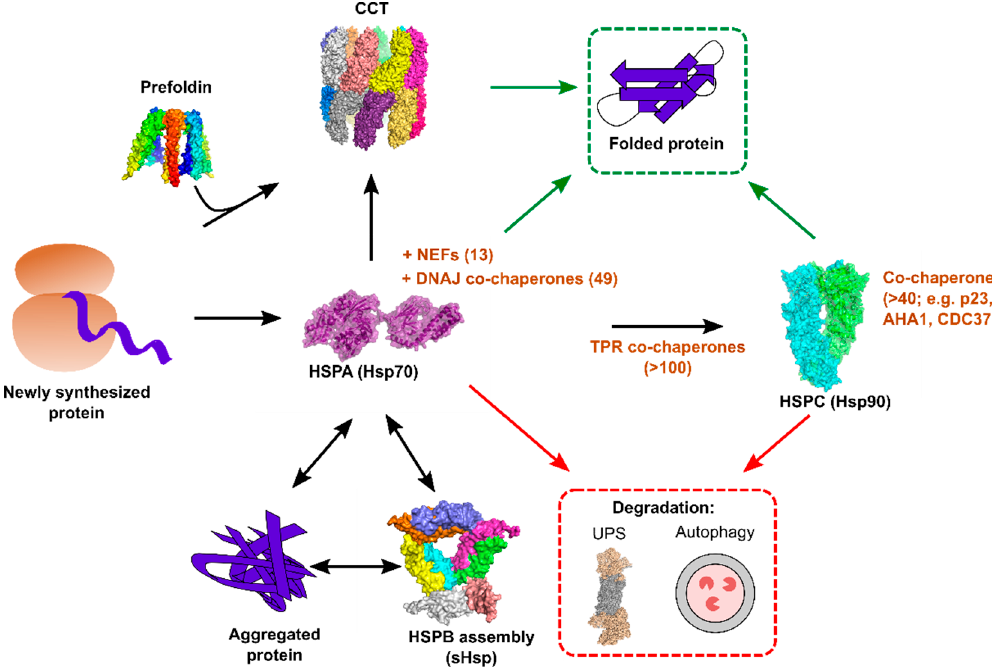
Figure 1. Overview of the major cytoplasmic chaperone systems in human cells. Newly translated proteins interact cotranslationally with HSPAs/Hsp70s, which function together with 49 co-chaperones of the DNAJ family and 13 nucleotide exchange factors (NEFs). Client proteins can either complete their folding via interaction with Hsp70s (green arrows) or be transferred to downstream chaperone systems. Certain client proteins require further interaction with HSPC/Hsp90, and numerous tetratricopeptide repeat (TPR) domain co-chaperones help bridge these two chaperone systems. As for Hsp70, Hsp90 function is critically dependent on a large number of co-chaperones. The chaperonin containing tailless complex polypeptide 1 (CCT) can either act downstream of Hsp70 to fold proteins, or it can receive client proteins from its co-chaperone, prefoldin. Under conditions of aberrant folding or cellular stress, protein aggregates can form in the cell, and these are refolded by Hsp70, together with small heat shock proteins (HSPB/sHsps). Finally, both Hsp70 and Hsp90 can direct proteins towards cellular degradation pathways for their disposal (red arrows). Structures were produced using PyMol version 3.5.2, and they are: Hsp70 (PDB: 2KHO), Hsp90 (PDB: 2O1V), CCT (PDB: 3IYF), sHSP (PDB: 1SHS), Proteasome (PDB: 5GJR).